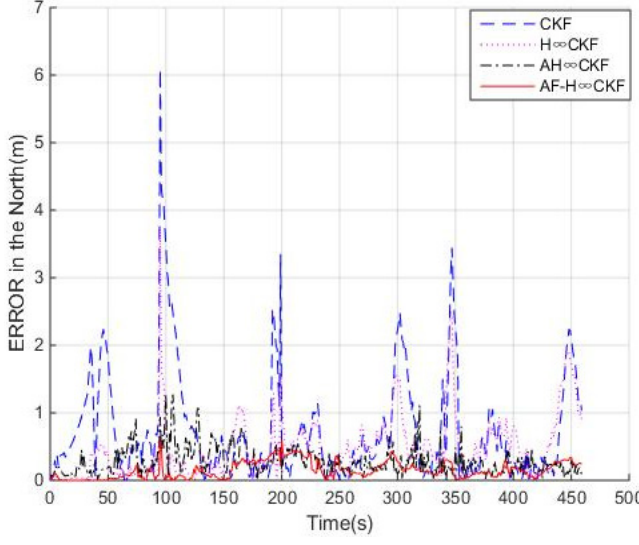
Figure 12. Error in the north. Table 2. Comparisons of the four algorithms.